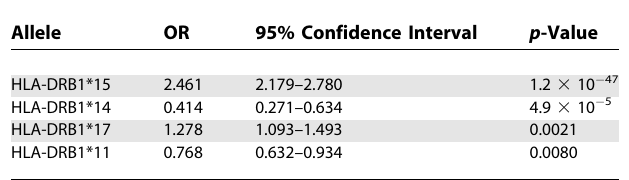
Table 6. Allelic ORs of MS for Associated Alleles at the HLA-DRB1 Locus, Relative to All Non-associated